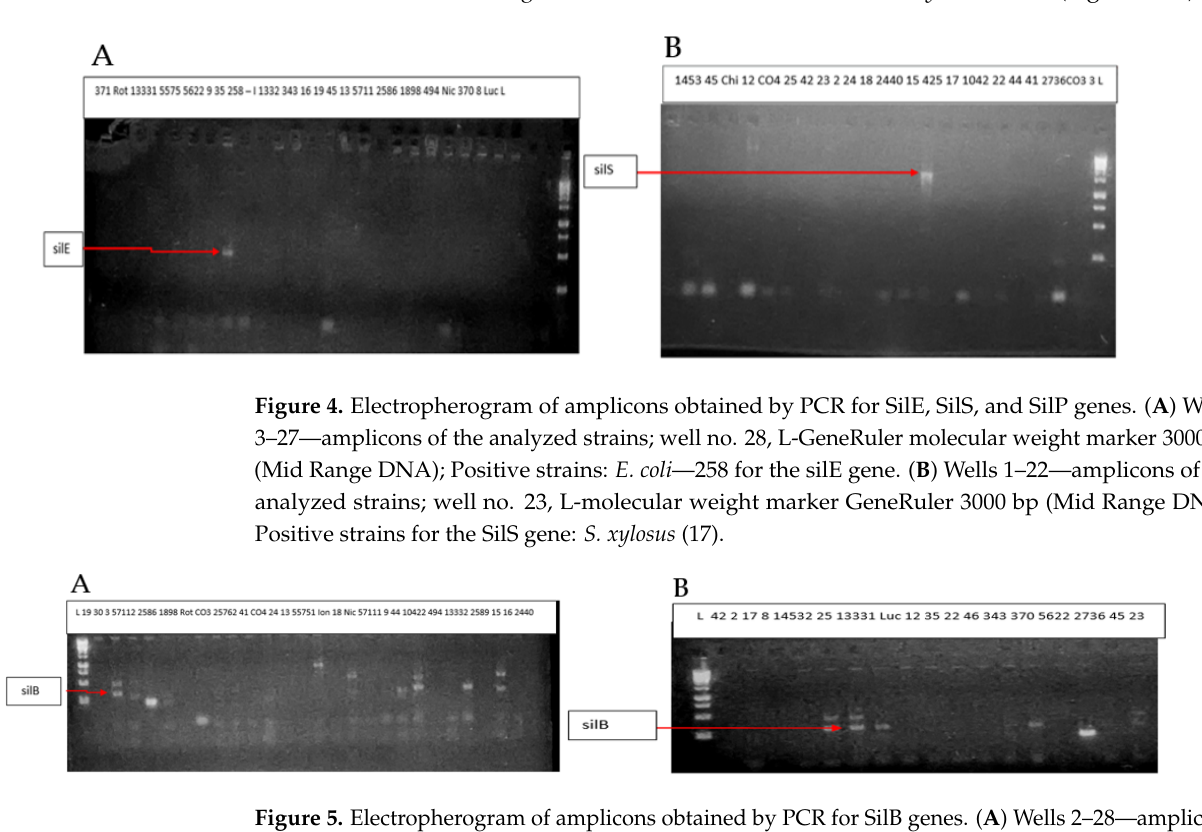
Figure 5. Electropherogram of amplicons obtained by PCR for SilB genes. ( A ) Wells 2–28—amplicons of the analyzed strains; well no. 1, L-Molecular Weight Marker GeneRuler 3000 bp (Mid Range DNA); Positive strains: S. aureus number 3015 for the SilB gene. ( B ) Wells 2–19—amplicons of strains 42–23; well no. 1, L-Molecular Weight Marker GeneRuler 3000 bp (Mid Range DNA); Positive strains for SilB gene: number 14532— P. aeruginosa ; 25— S. aureus ; 13331— P. aeruginosa ; 370— S. aureus .